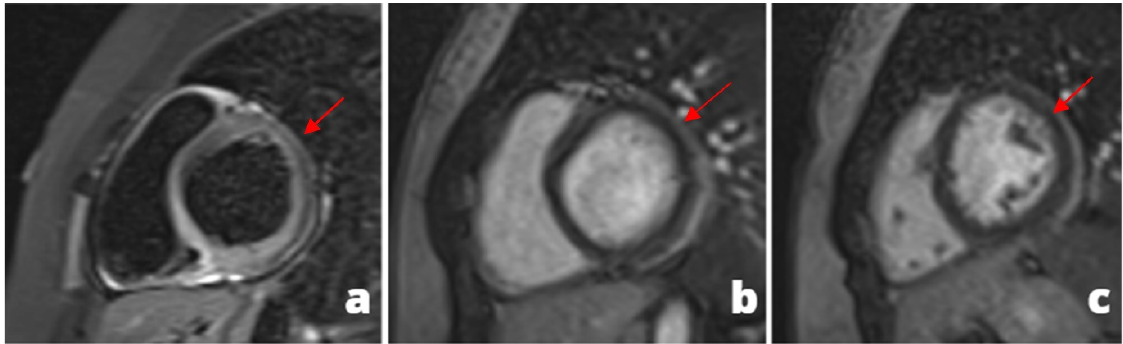
Figure 2. A 28 y/o man presented at the emergency department with fever and chest pain. At the admission, cardiac enzymes were elevated and ECG did not show any alteration. Cardiac MRI was performed 1 day later and revealed pericardial alteration: presence of edema ( a ) and post-inflam- matory fibrosis ( b , c